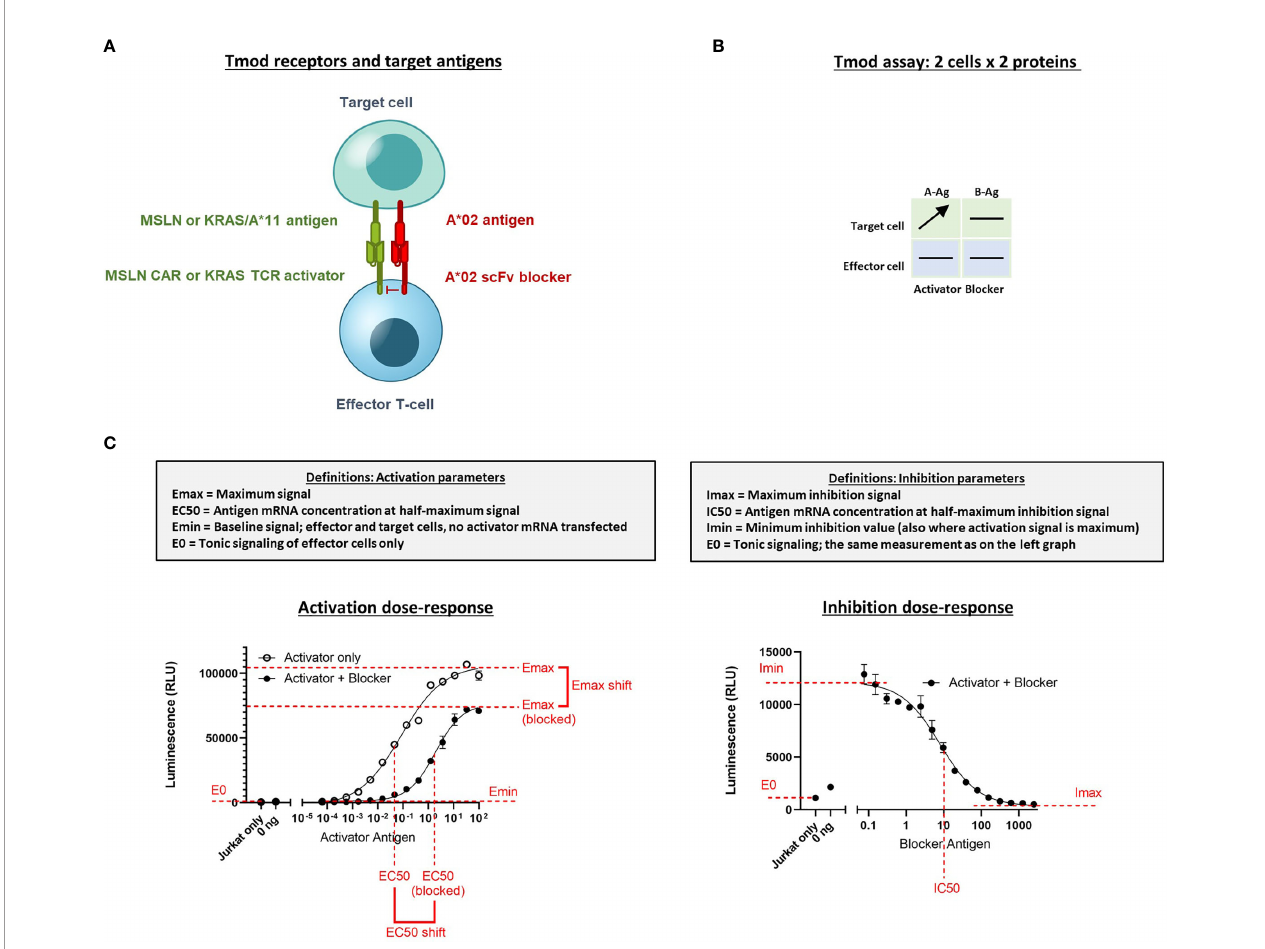
FIGURE 1 | Diagram of Tmod system and assays to measure quantitative response in Jurkat cells. (A) Receptor components consist of an activator receptor (CAR or TCR) and a blocker receptor. The illustration shows a CAR, but the activator can also be a TCR. (B) The 2x2 box shows an example of a simple diagram that summarizes how the receptors/Ags are varied in the experiments described. Horizontal lines indicate constant protein level in experiment; arrow indicates titrated protein. In this example the A-Ag is titrated and the other molecules are held constant. A-Ag, activator Ag; B-Ag, blocker Ag. (C) Graphical illustration and de fi nition of key parameters derived from Jurkat cell NFAT-luciferase reporter assays. Curves are example dose-response